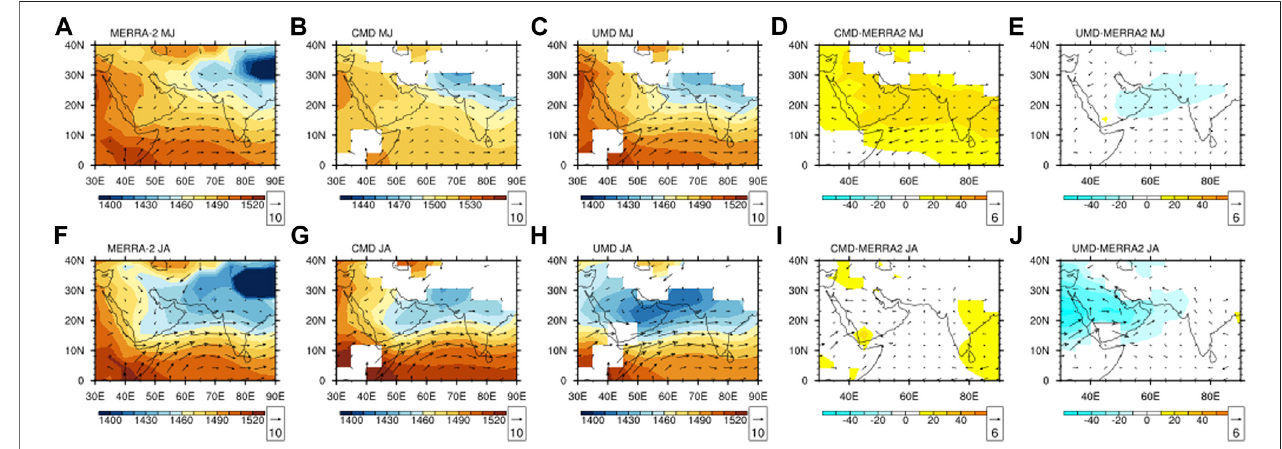
FIGURE 4 | The averaged 850 hPa wind (vectors, unit: m/s), geopotential height (shaded, unit: gpm) and their differences from MERRA-2 and simulations in the early monsoon May – June; (A – E) and late monsoon July – August; (F – J) seasons in MERRA-2 reanalysis (A,D) , CMD simulations (D,E) , UMD simulations (C,F) ,